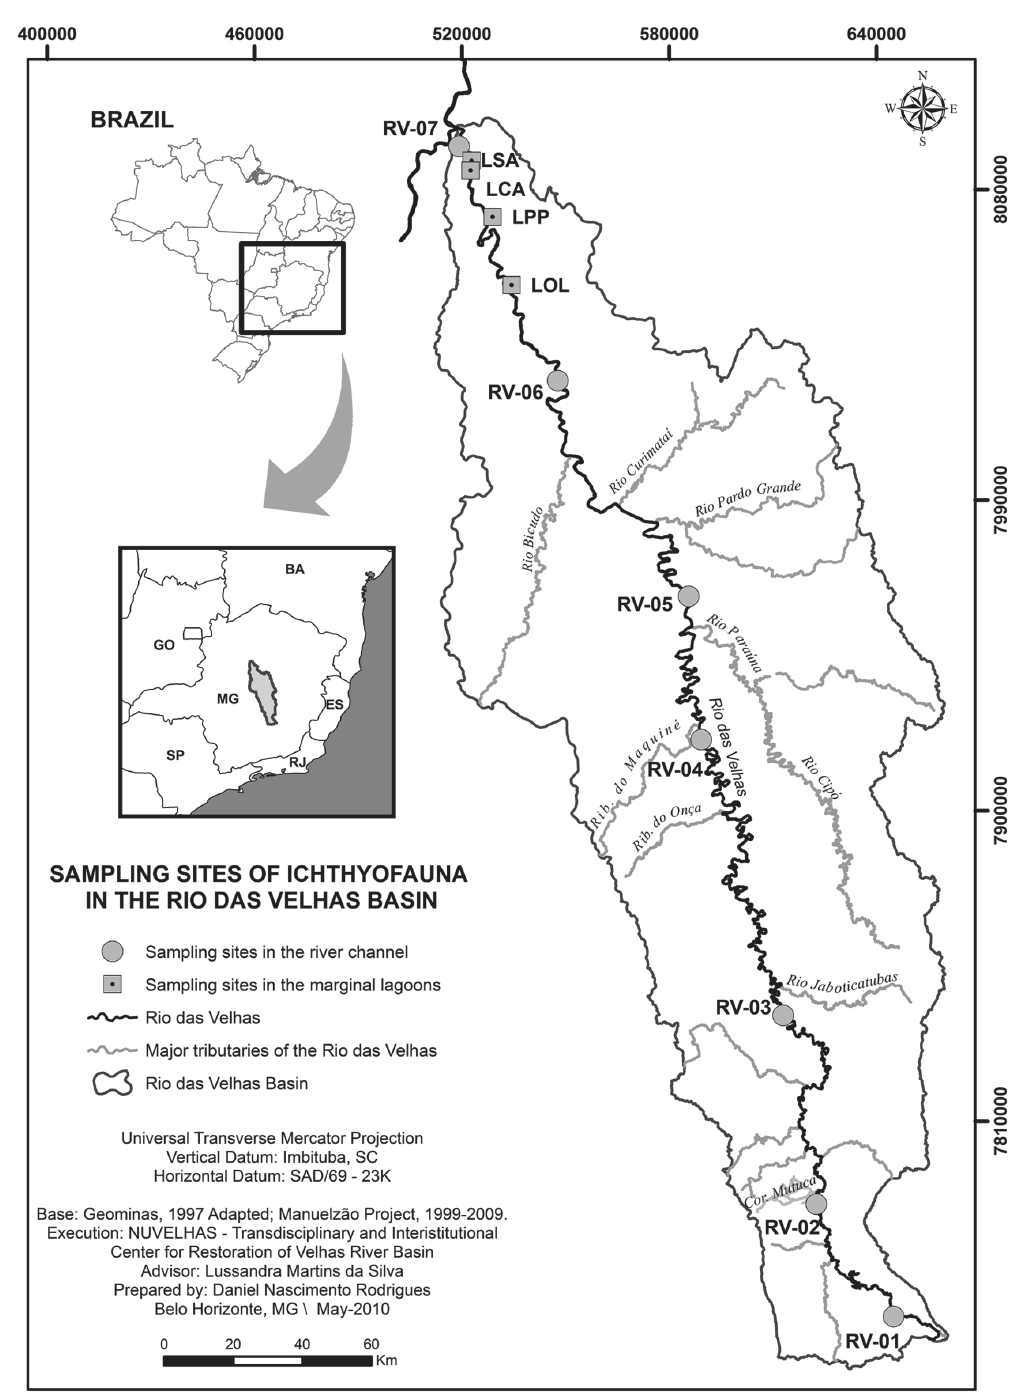
Fig. 1. Map of the rio das Velhas basin with locations of sampling